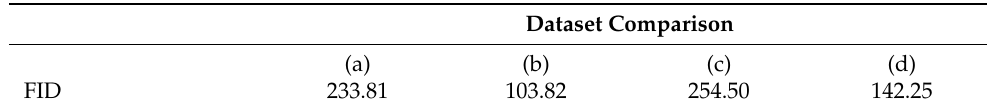
Table 4. Results of the computed FID: (a) real (recolored) images vs. fake images (generated back- ground), (b) real (recolored) images vs. fake images (replaced background), (c) real images vs. fake images (generated background), (d) real images vs. fake images (replaced